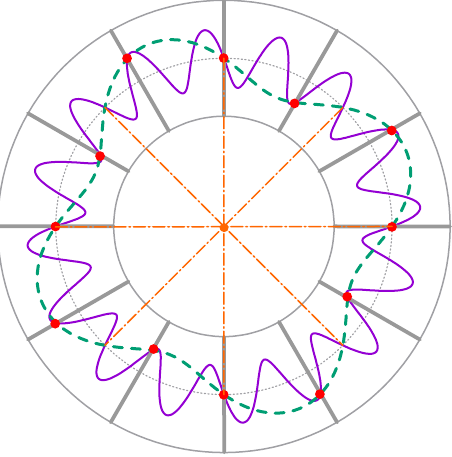
Figure 1. Example of a spinning forcing function and aliasing